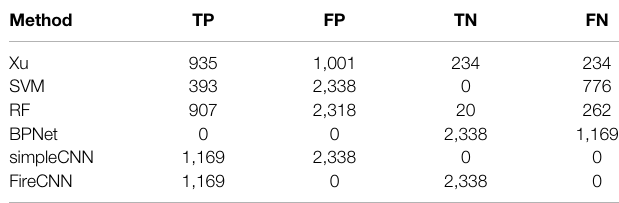
TABLE 3 | Additional results from the comparison of